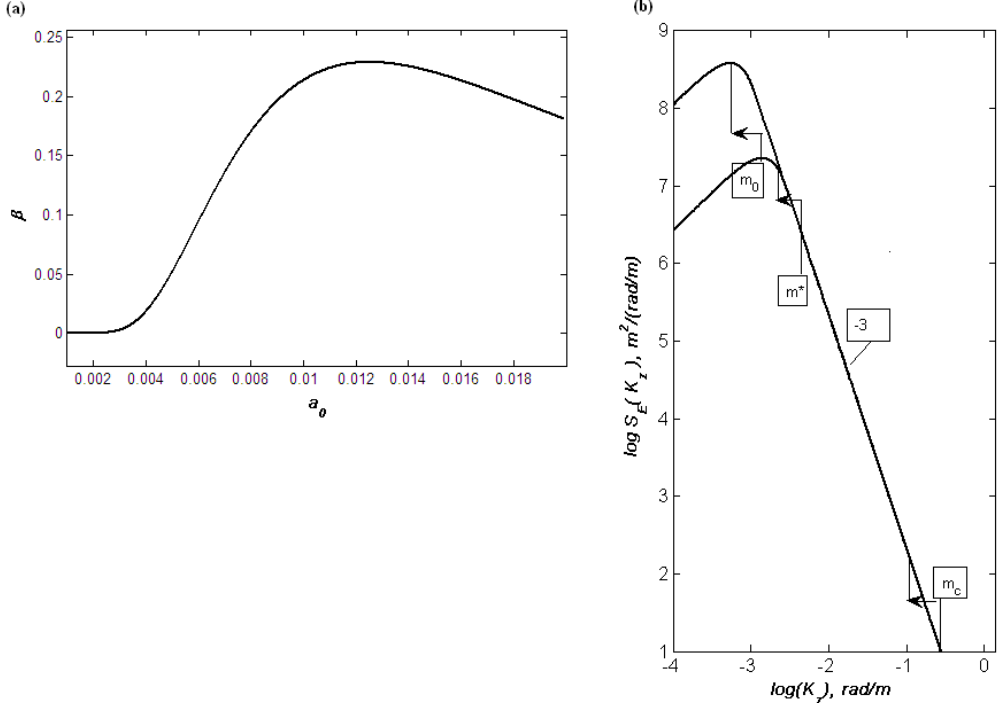
Fig. 9. Vertical wave number spectrum of a random internal wave field, given by Eqs. (62–63), and its amplitude β . (a) β as a function of the parameter a 0 ≡ M 2 / 8 characterizing the degree of nonlinearity of the wave field. (b) Model spectrum S 1 E (k z ) calculated for two altitudes, which are 15km